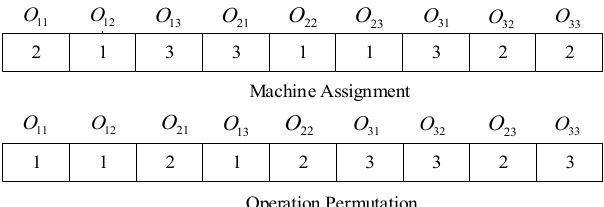
Figure 2. The encoding scheme.